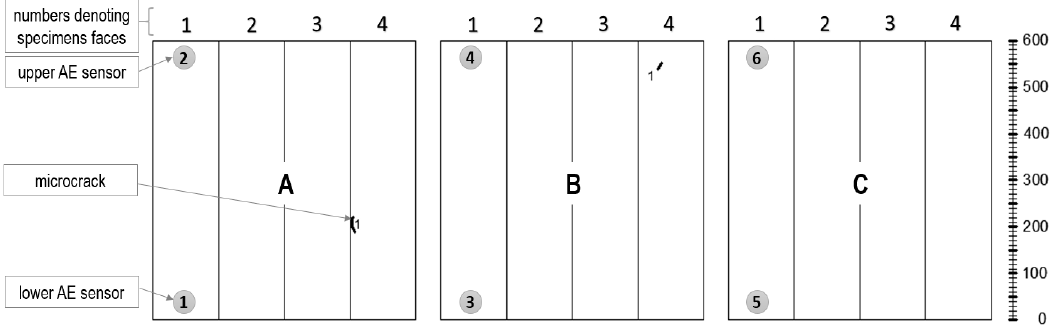
Figure 11. Surface microcracks distribution on sides of the W7 samples.